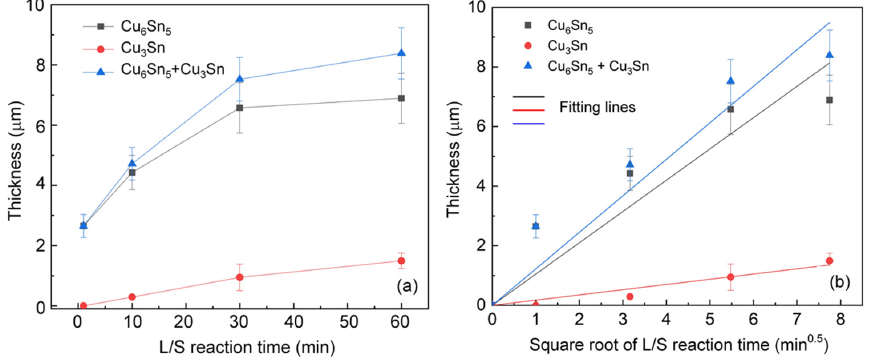
Figure 3. Thicknesses of IMCs as a function of ( a ) the liquid/solid reaction time and ( b ) the square root of the reaction time. Table 1. Growth rate constants ( k ) of Cu 6 Sn 5 , Cu 3 Sn, and Cu 6 Sn 5 + Cu 3 Sn for the liquid/solid reactions